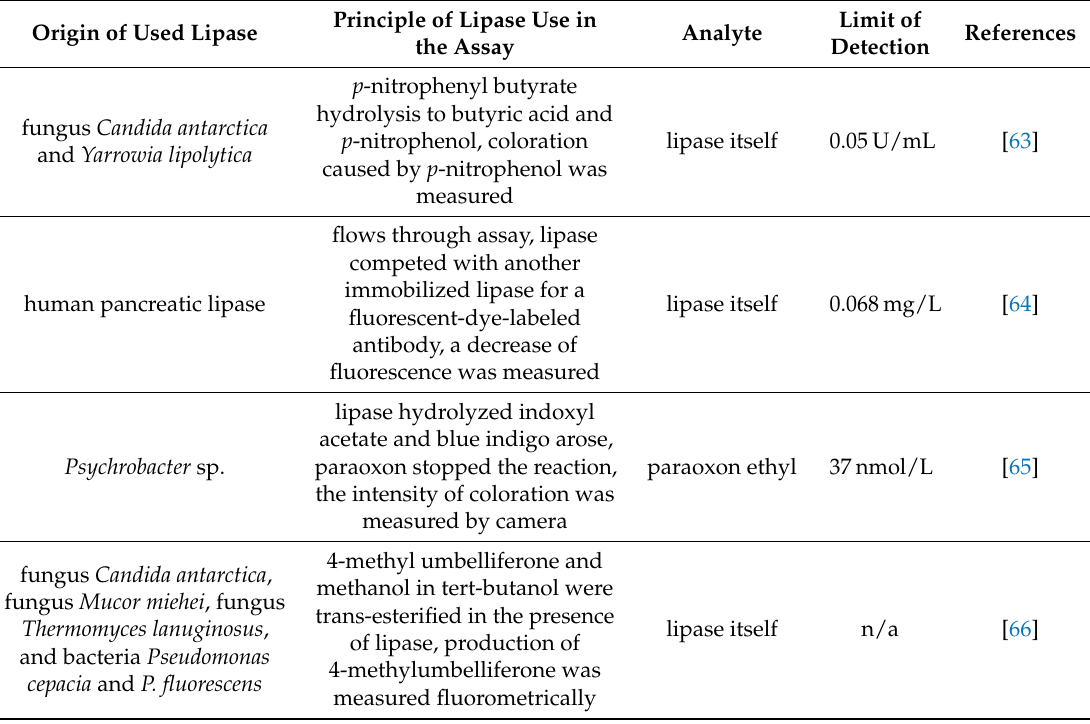
Figure 7. The principle of the fluorometric assay of lipase activity by the transesterification of fluorogenic 4-methyl umbelliferone to fluorescent 4-methylumbelliferone. Table 4. The overview of lipase-based optical